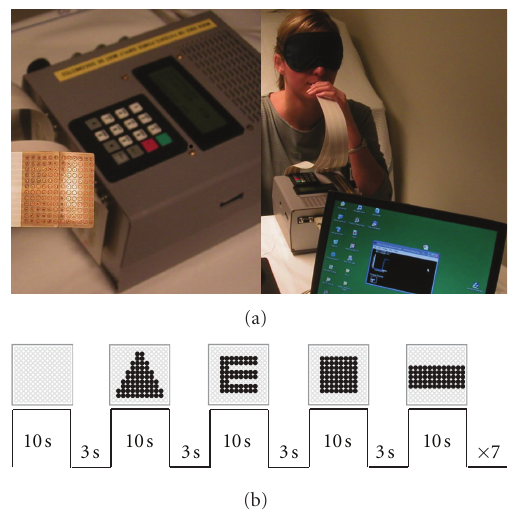
Figure 1: Experimental setup. (a) The tongue display unit (TDU) and its components. (b) The fMRI block design. During each of the two fMRI runs, 7 stimulation blocks were presented. One block consisted of a rest period and Shape stimuli used during training and